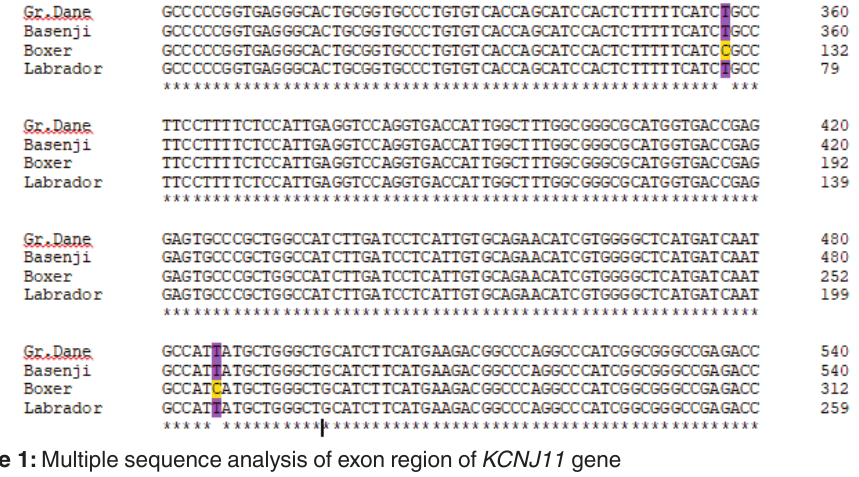
Figure 1: Multiple sequence analysis of exon region of KCNJ11 gene